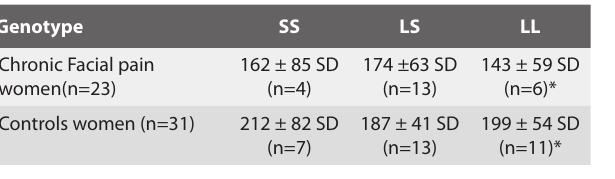
Table 8. The percentage long-term significant clinical improvement in facial pain in the different genotypes after three-year follow-up. Patients with LL genotype did best but the statistical difference is non-signifi- cant, (chi squared test,